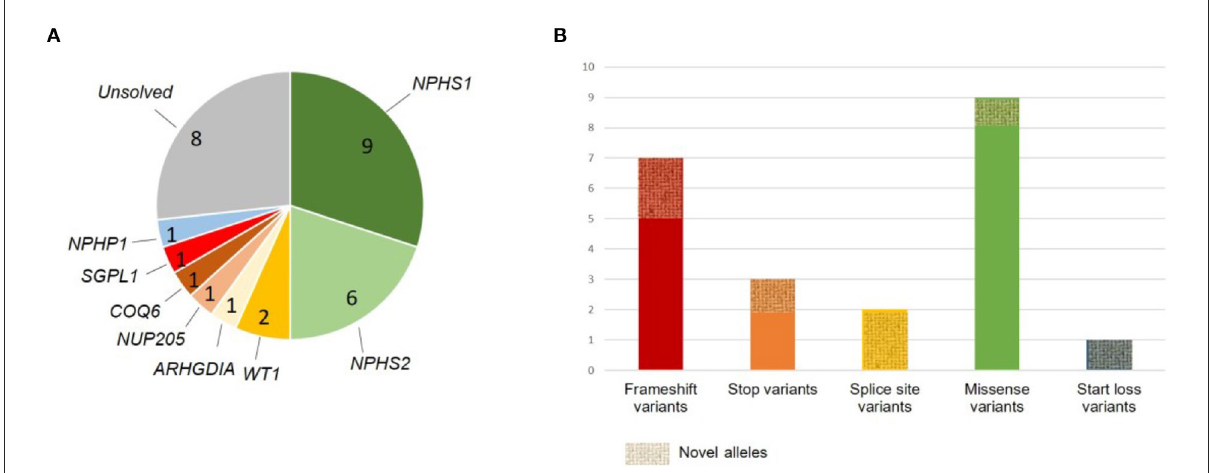
FIGURE1 Summary of genetic findings. (A) Gene-specific distribution of identified disease-causing variants and one variant of uncertain significance; unsolved cases are shown in gray. (B) Variant type distribution. Alleles not previously reported are marked as novel alleles.